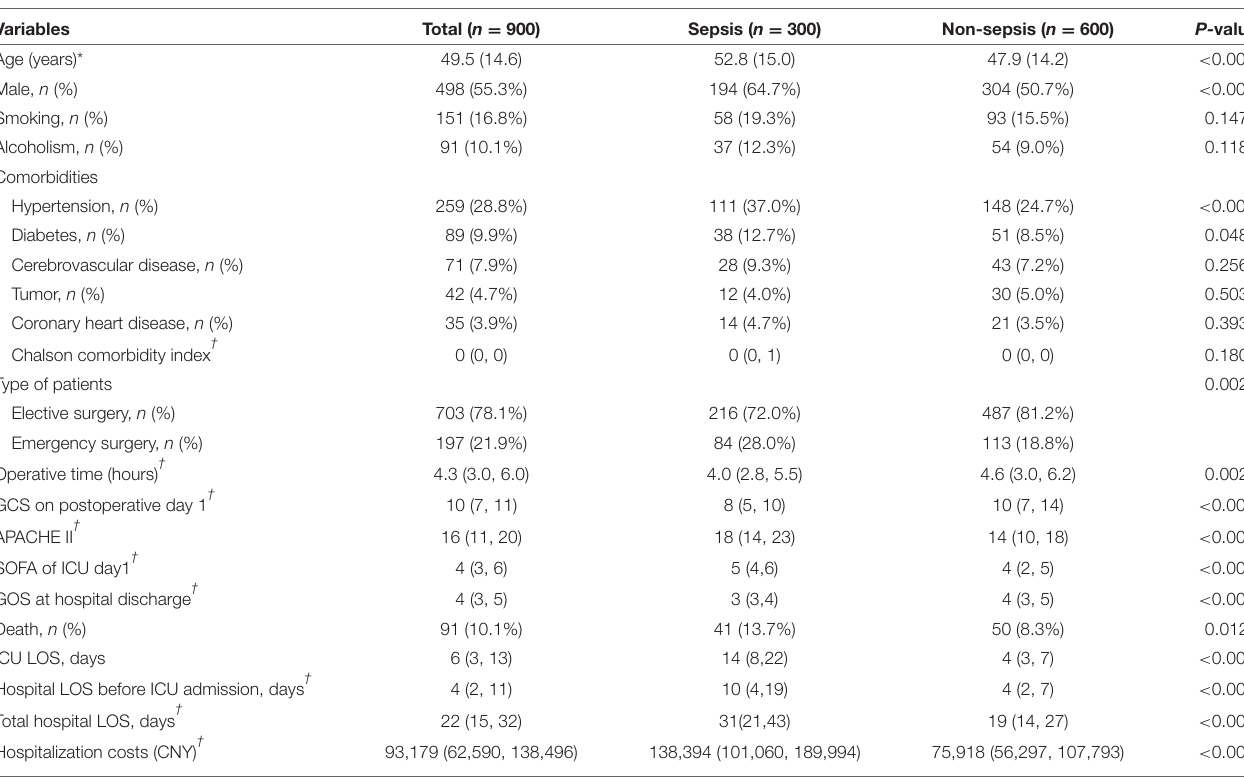
TABLE 1 | Demographic characteristics and outcomes of